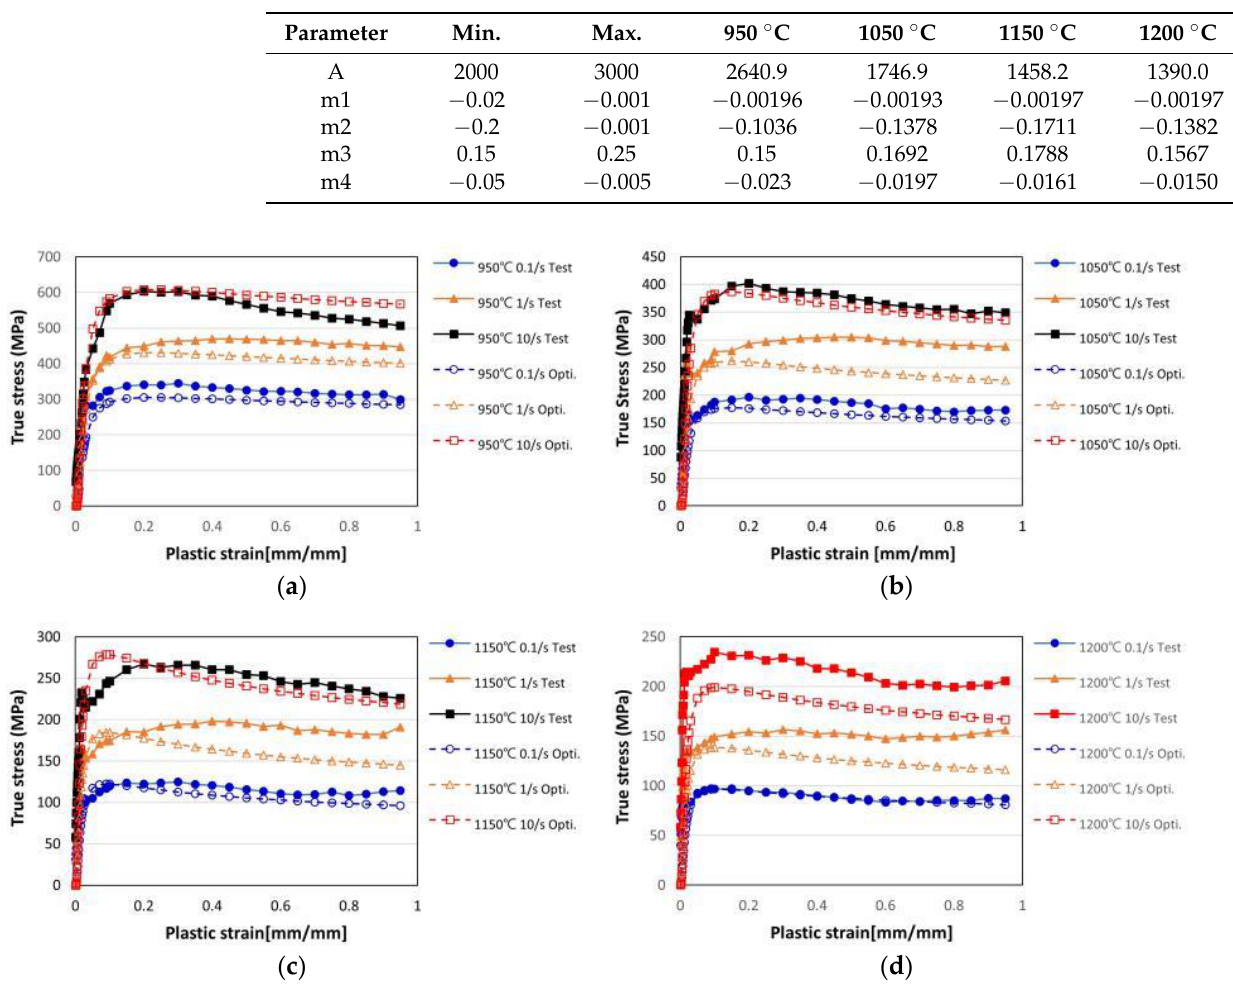
Figure 10. Comparison of flow stress before and after optimization: ( a ) 950 °C, ( b ) 1050 °C, ( c ) 1150 °C, and ( d ) 1200 °C.